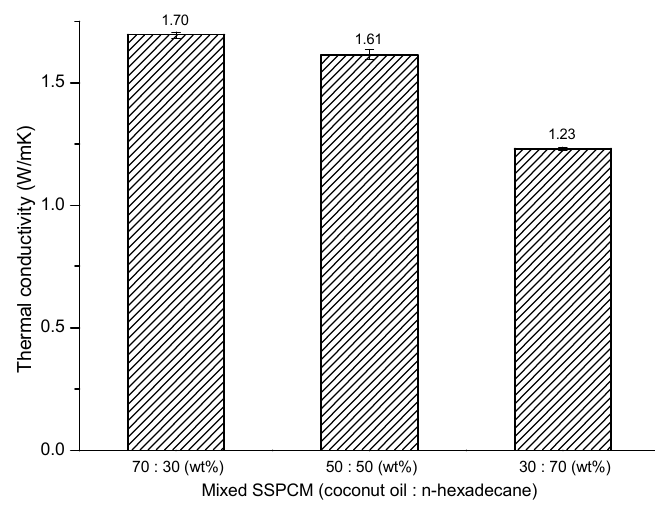
Figure 6. Thermal conductivity of Mixed SSPCMs.